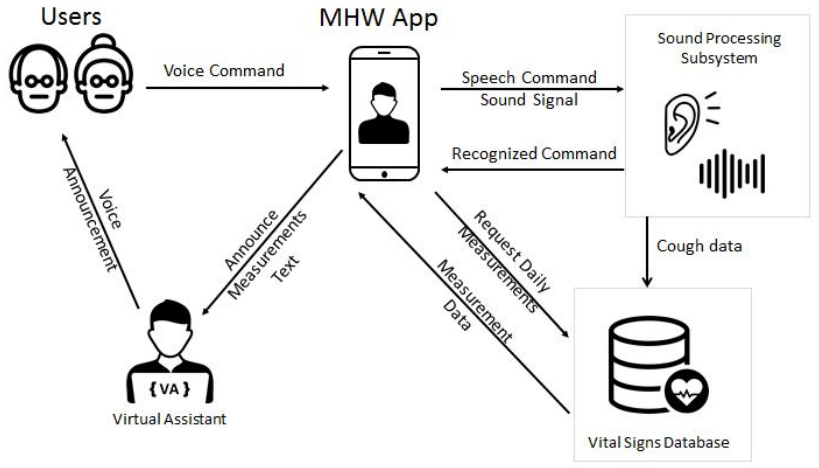
Figure 14. Avatar communication workflow.